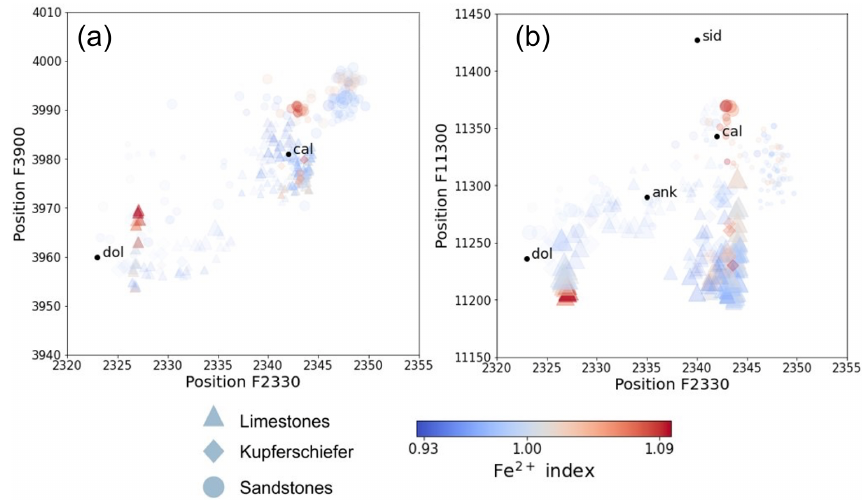
Figure 7. The 10cm averaged position of carbonate-related spectral absorption features (a) F3900 and (b) F11300 plotted using the F2330 feature as a reference. Size is proportional to the depth of the feature in the y axis, and transparency is proportional to the depth of the F2330 feature. Colour indicates the value of the ferrous iron feature (Cudahy et al., 2008) and appears to account for some of the variation observed in the MWIR and